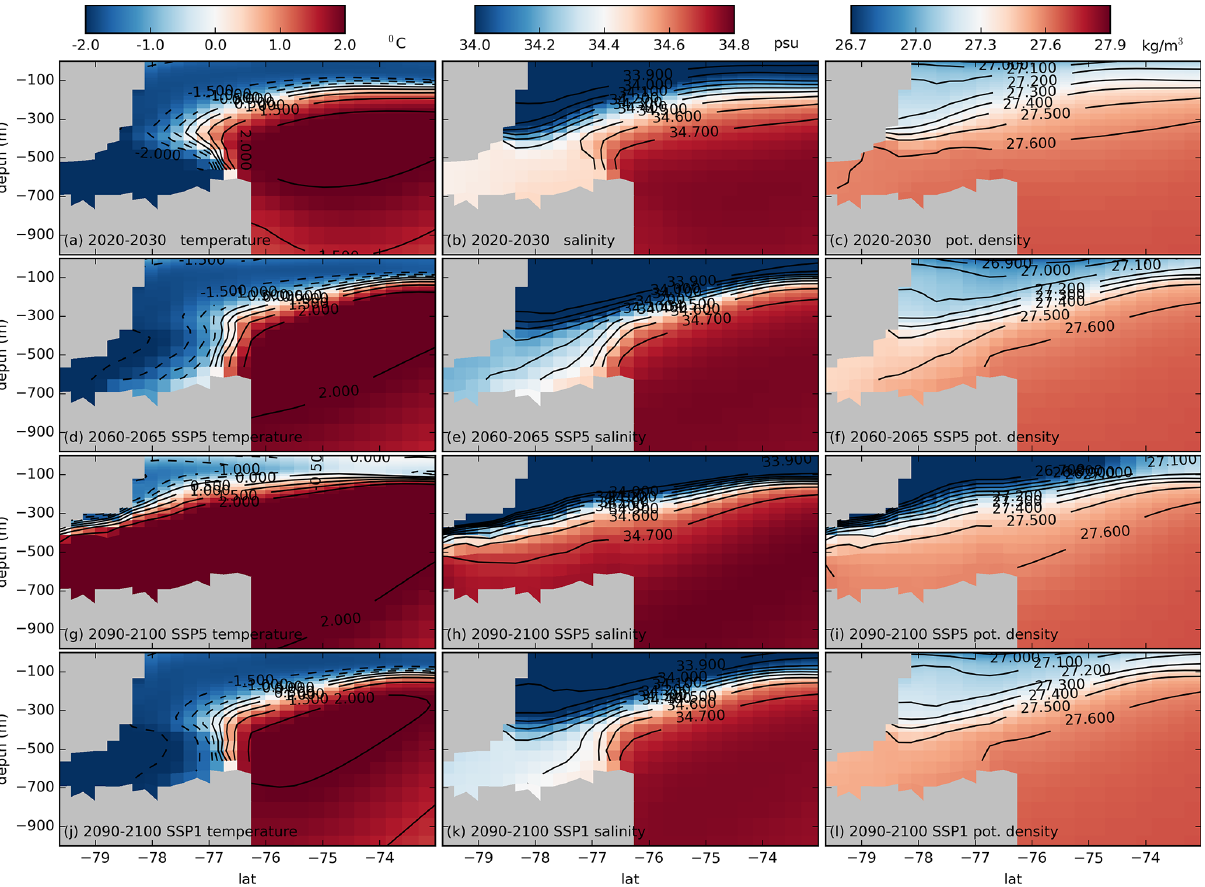
Figure 11. Temperature, salinity and potential density profile in a Little America Basin section (indicated by the green line in Fig. 10a) for (a–c) SSP5–8.5 for years 2020–2030, (d–f) SSP5–8.5 for years 2060–2065, (g–i) SSP5–8.5 for years 2090–2100 and (j–l) SSP1–1.9 for years 2090–2100.